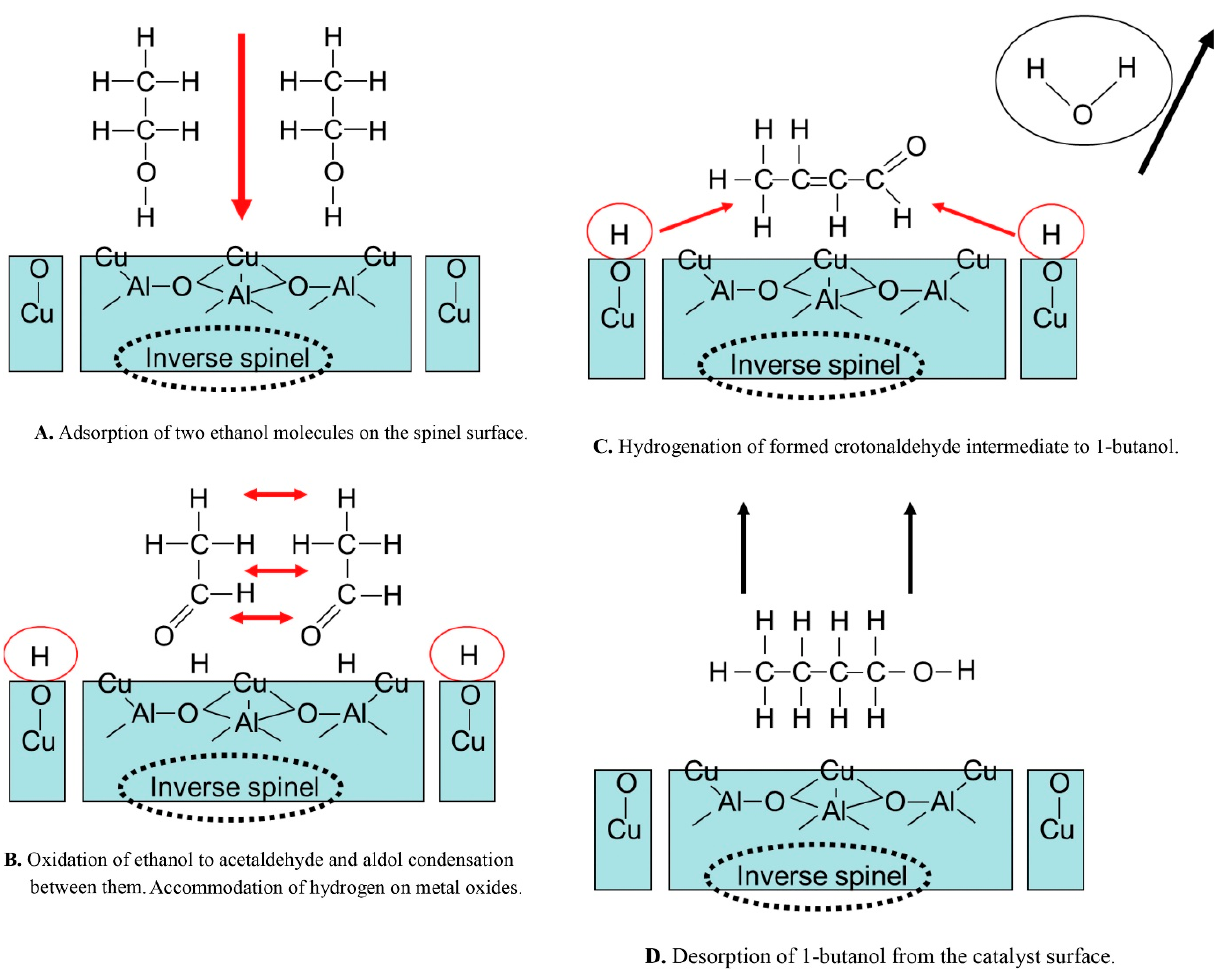
Figure 2. Proposed ethanol conversion mechanism for the production of n-butanol on alumina-supported metal catalysts at 240 °C under 7 MPa. Reprinted from Riittonen et al. [58], Copyright (2014), with permission from Elsevier. Table 1. Catalysts used for the conversion of ethanol to n-butanol. All the results are obtained from earlier literature. Catalyst Reaction Conditions Ref. Phase Selectivity (%)